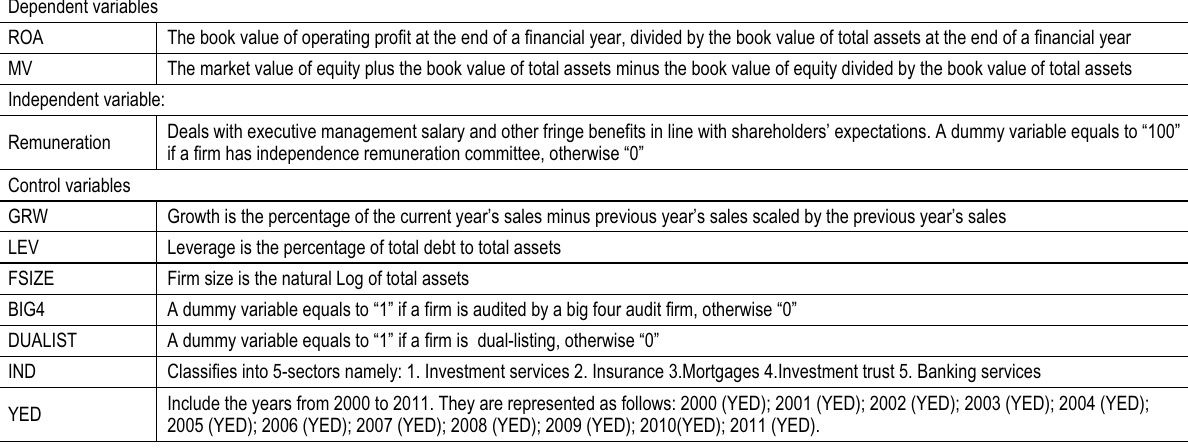
Table 2. Summary of definitions and explanation of variables